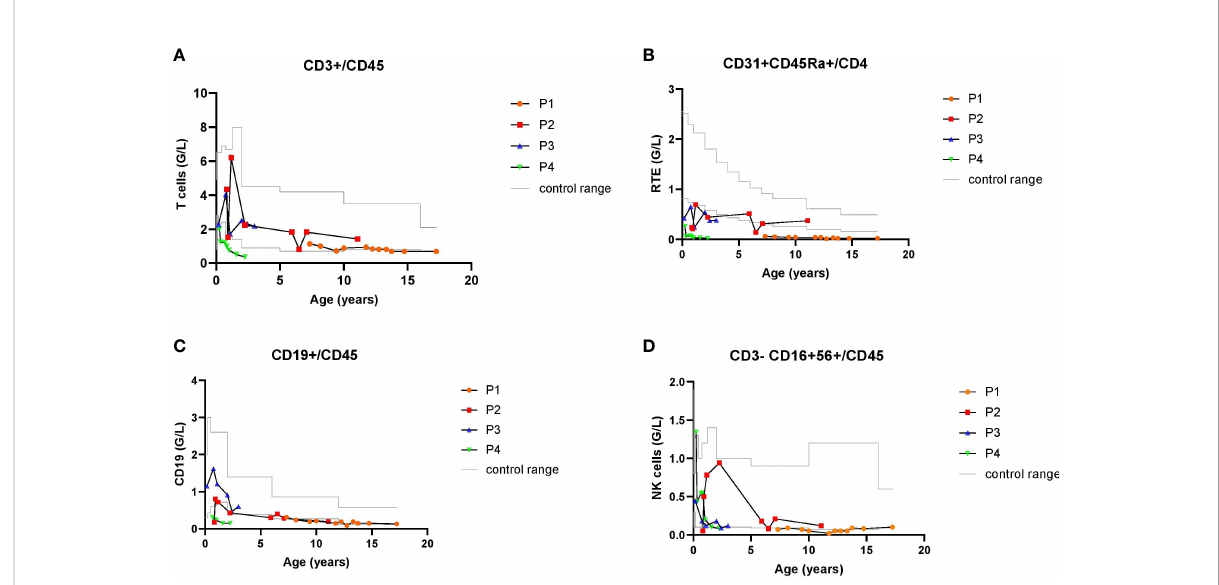
FIGURE 1 Longitudinal lymphocyte values of P1-4 with Jacobsen syndrome during their follow-up between 2 and 10 years: total T cells counts (A) , recent thymic emigrants, RTE (B) , CD19+ B cells (C) and CD16+CD56+ NK cells (D) . Gray lines delineate age-speci fi c upper and lower reference values of the cell counts